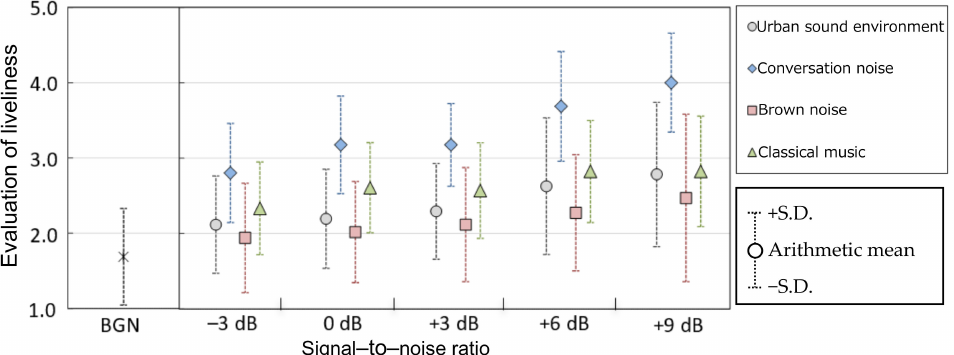
Figure 4. Evaluation of “liveliness” for each sound environmental condition. The plots in this figure represent the arithmetic mean, and the error bars indicate the standard deviation.